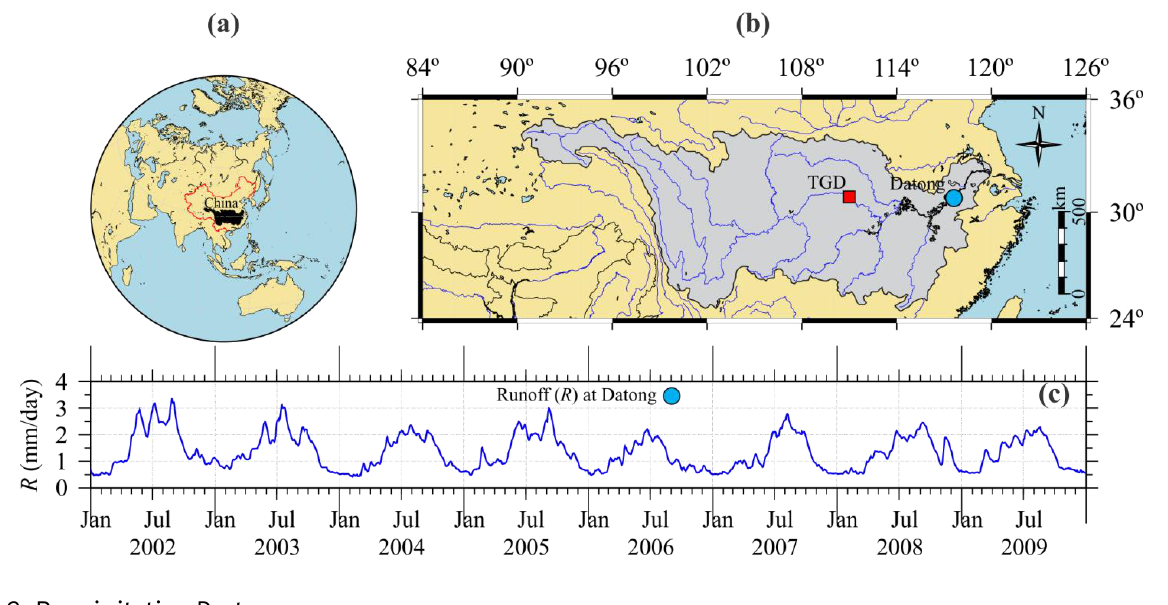
Figure 1. ( a ) Location of the study area in China; ( b ) Yangtze River basin (shadowed portion with an area of approximately 1.8 × 10 6 km 2 ), Three Gorges Dam (TGD) and the Datong Hydrologic Station. The graphical scale is related to the parallel 30°; ( c ) Daily net surface runoff ( R ) of Datong Hydrologic